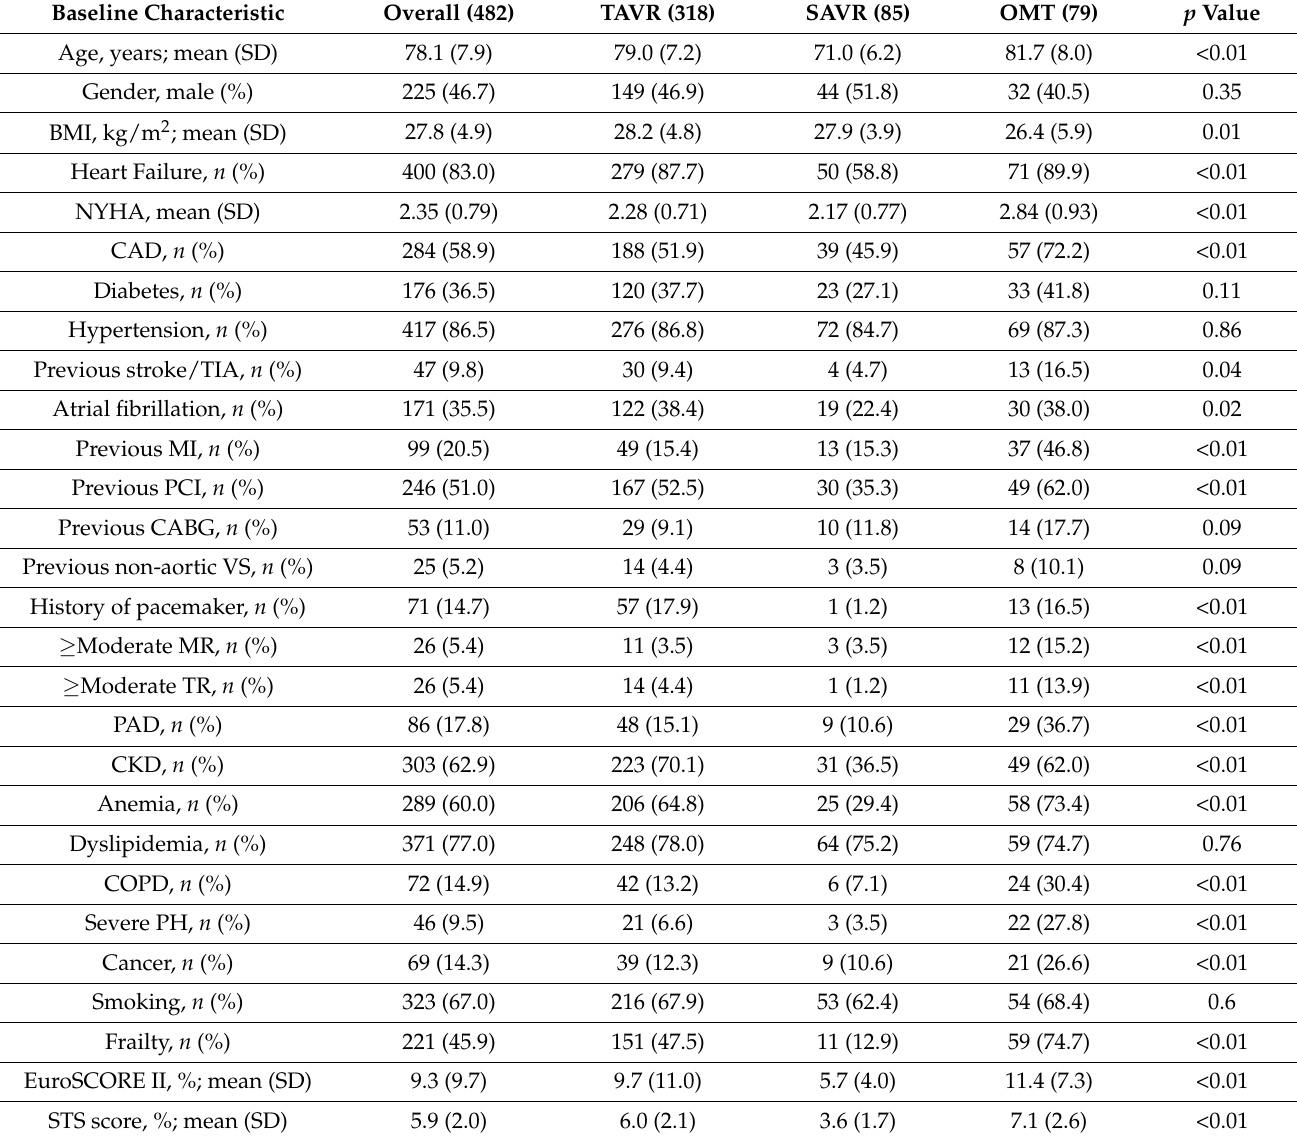
Table 1. Baseline clinical